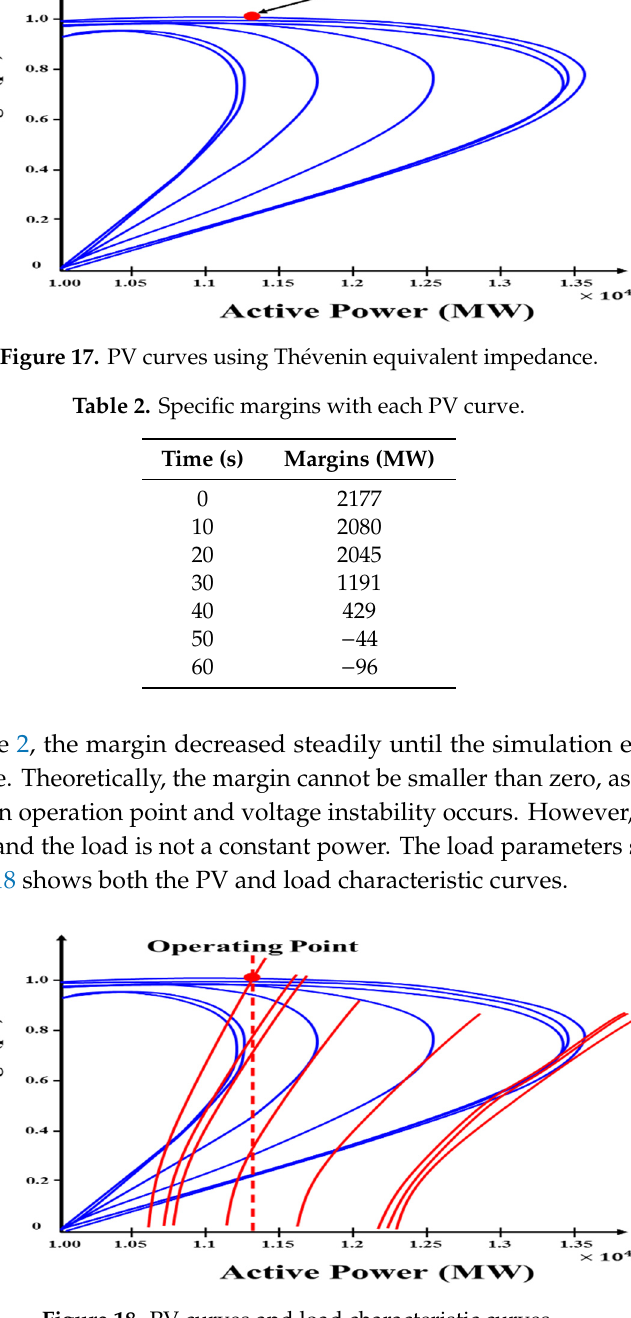
Figure 17. PV curves using Thévenin equivalent impedance.